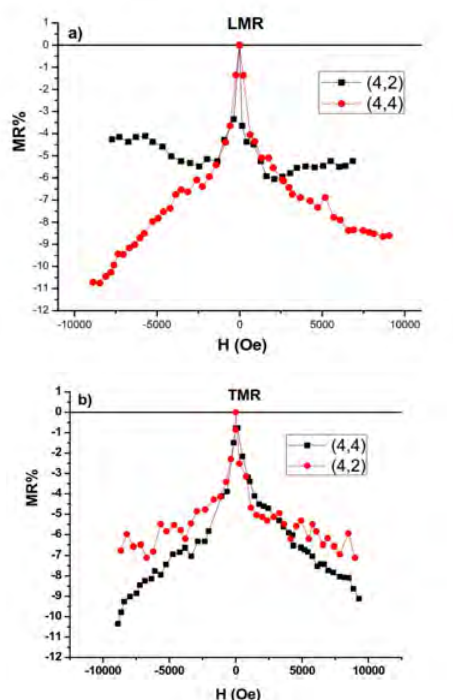
Fig. 4. LMR and TMR curves of Ni-Co/Cu multilayers in different Cu layer